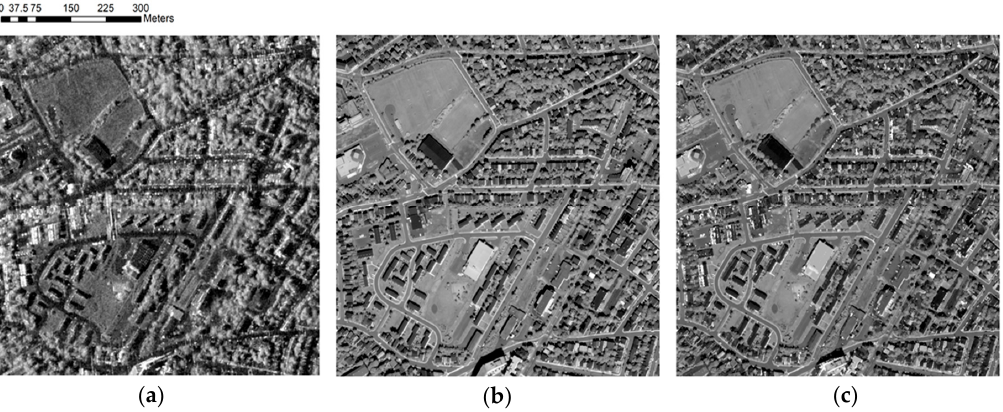
Figure 12. Experimental images in the additional dataset (Site 1): ( a ) TerraSAR-X image acquired on 8 August 2019, ( b ) GeoEye-1 image acquired on 19 August 2019, ( c ) fusion result of the proposed